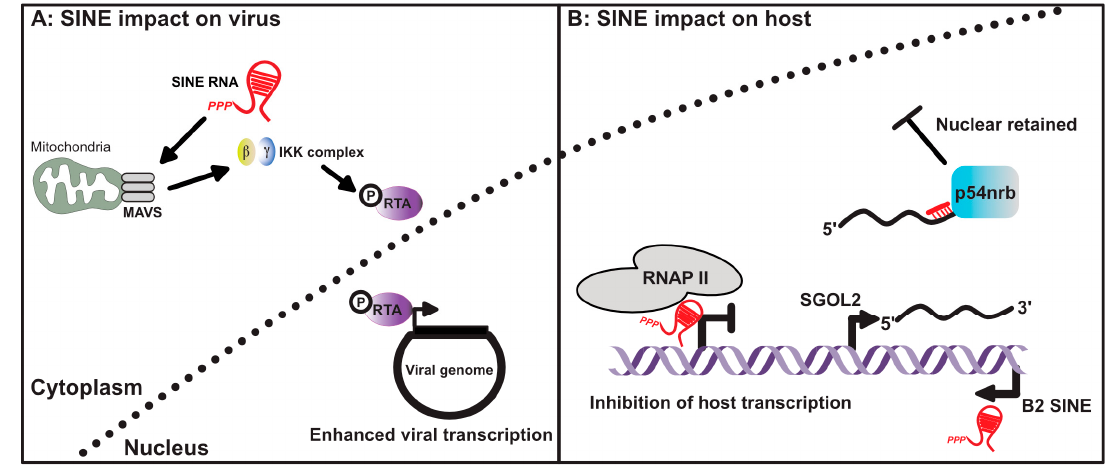
Figure 3. SINE RNA influences gene expression in virus infected cells. ( A ) Cytoplasmic SINE RNAs can activate the mitochondrial antiviral-signaling protein (MAVS), subsequently activating the IKK complex and promoting phosphorylation of the viral transcription factor RTA. Phosphorylation of RTA enhances its function as a viral transcription factor. ( B ) Nuclear localized SINE RNA can also inhibit host gene transcription by preventing RNAP II from properly engaging promoters. Transcriptional activation of SINEs within the 3’ untranscribed regions (UTRs) of host mRNAs can also lead to nuclear retention of the antisense mRNA. This occurs as a result of intermolecular RNA–RNA interactions between the mRNA and expressed SINE RNA, leading to the recruitment of